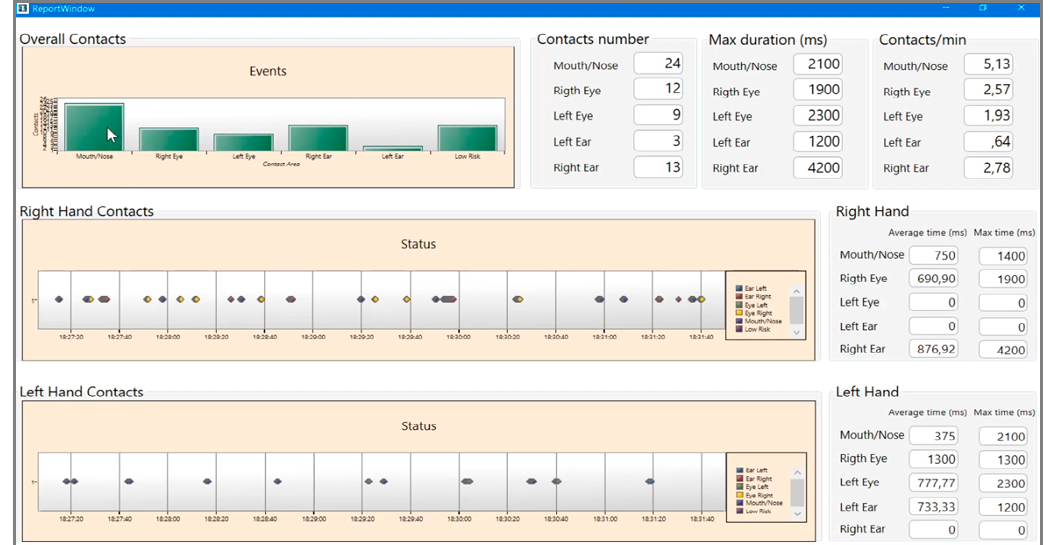
Figure A2. The report window of the HealthSHIELD tool prototype.